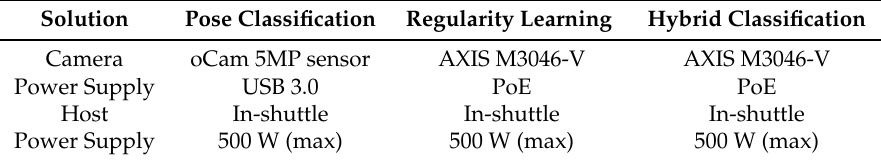
Table 3. Technical specifications of the equipment used in the experimental environment.